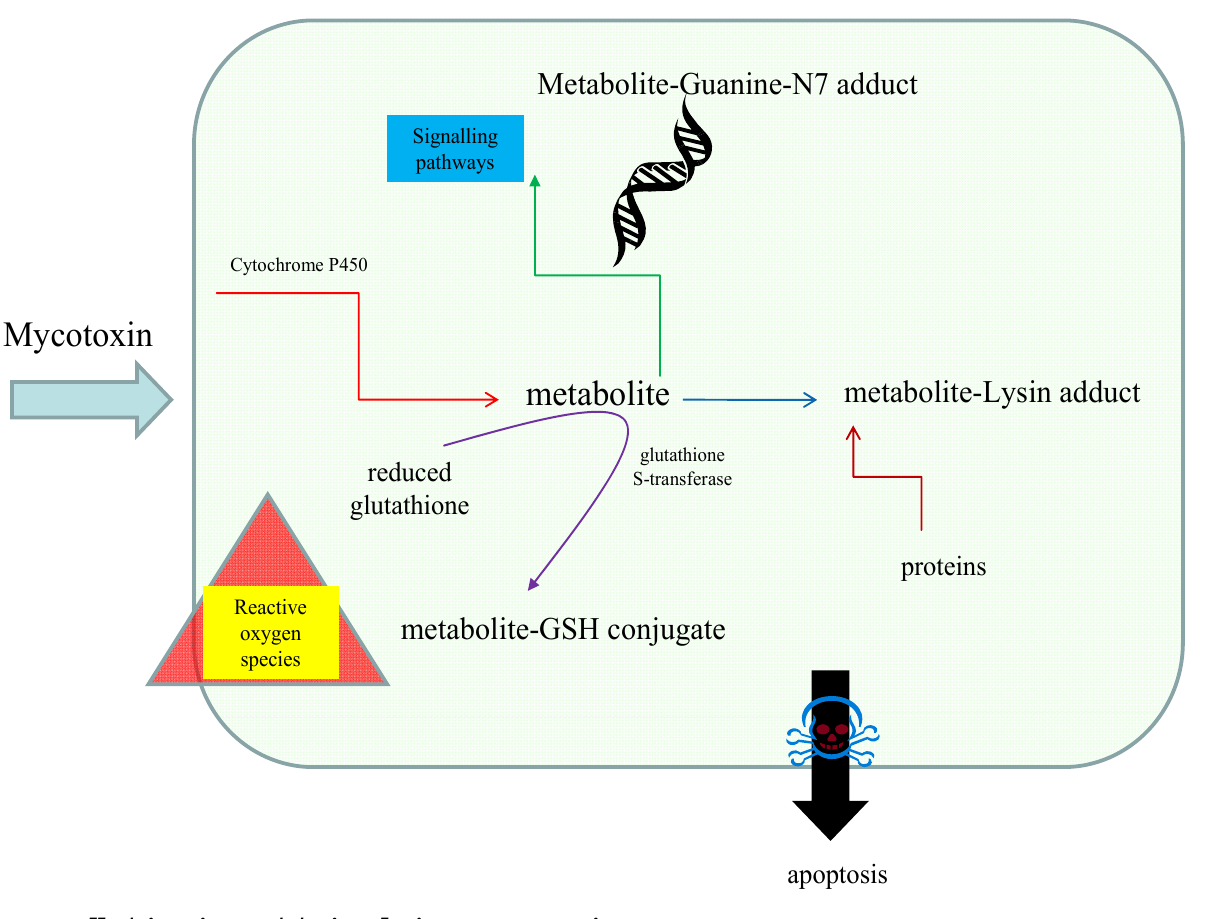
Figure 2. Simplified scheme of mycotoxin metabolism in